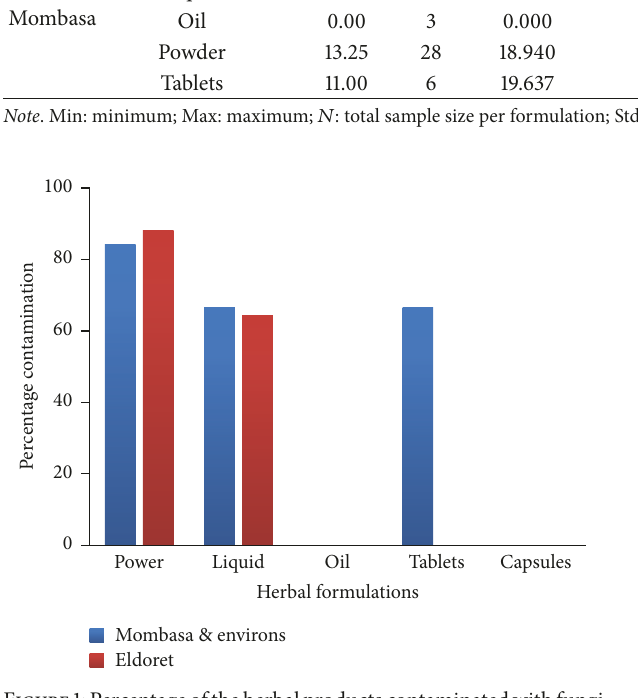
Figure1:Percentageoftheherbalproductscontaminatedwithfungi after 72 hours ( 𝑛